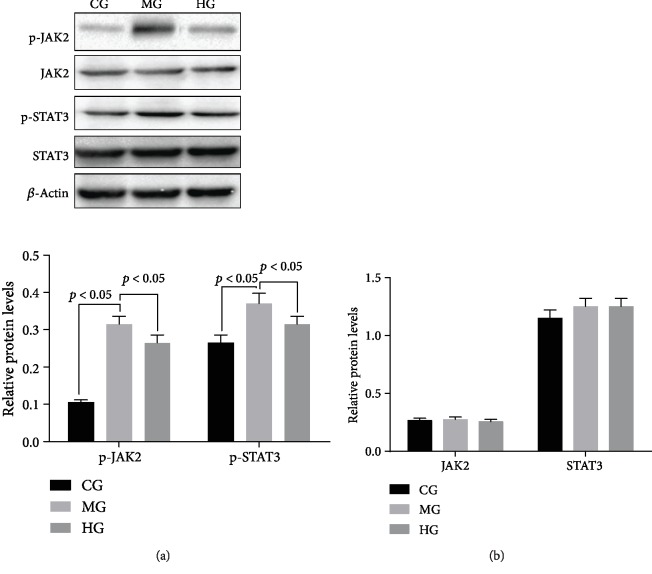
Western blot analysis of the effects of hydrostatin-SN10 on the relative protein levels of JAK2/STAT3 signaling. (a) Relative protein levels of p-JAK2 and p-STAT3. (b) Relative protein levels of JAK2 and STAT3. n = 12 for each group, and statistical difference was significant if p < 0.05.